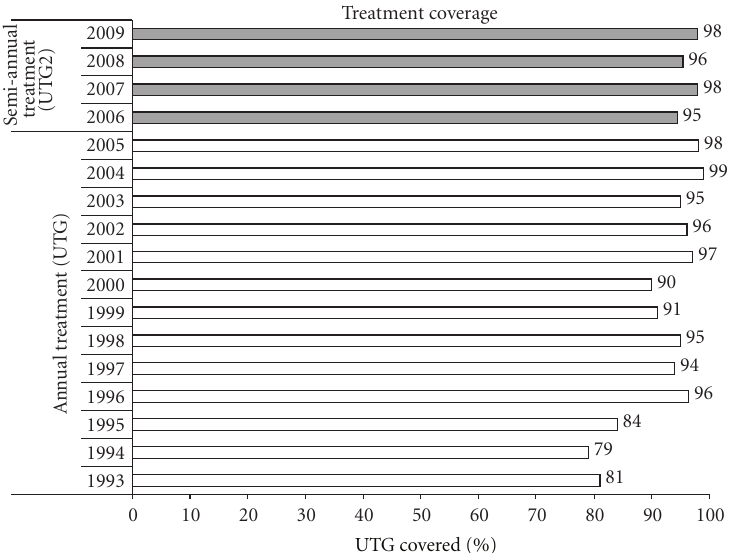
Figure 3: History of percent treatment coverage with ivermectin annually 1993 to 2005 (UTG), and twice yearly (UTG2) from 2006–2010 in Wadelai onchocerciasis focus, Uganda.